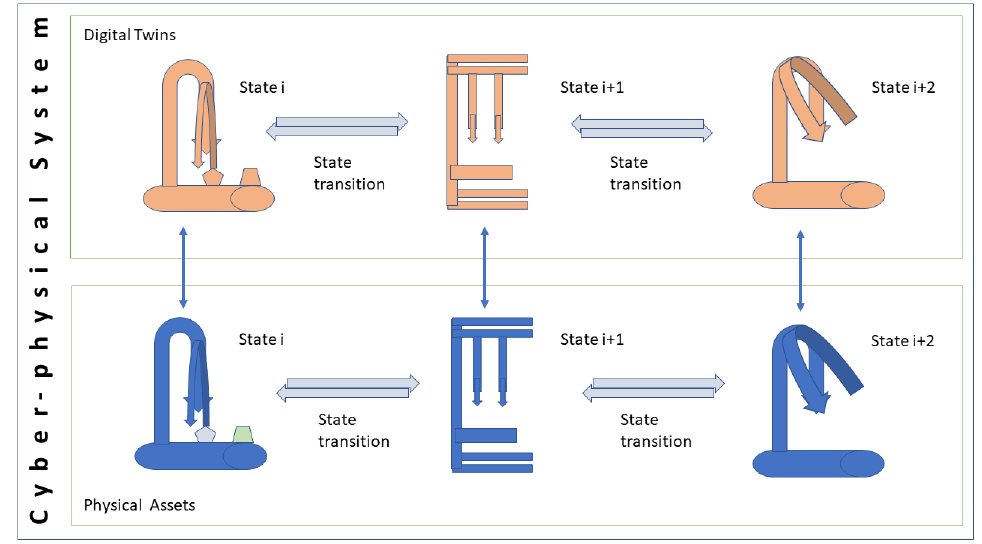
Figure 1. Digital twins and corresponding physical assets in cyber-physical settings in line with [5]. The DT is characterized by a two-way dynamic mapping between a physical object and a virtual model in cyberspace. In this context, the DT represents a kind of middleware